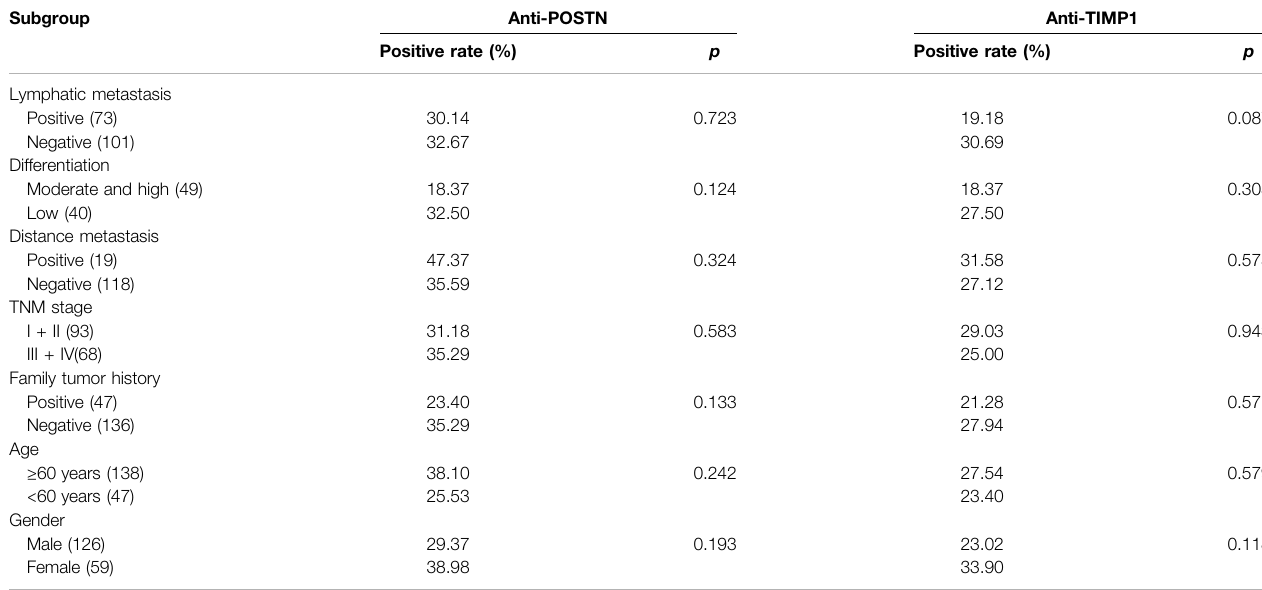
TABLE 3 | Positive frequencies of autoantibodies in